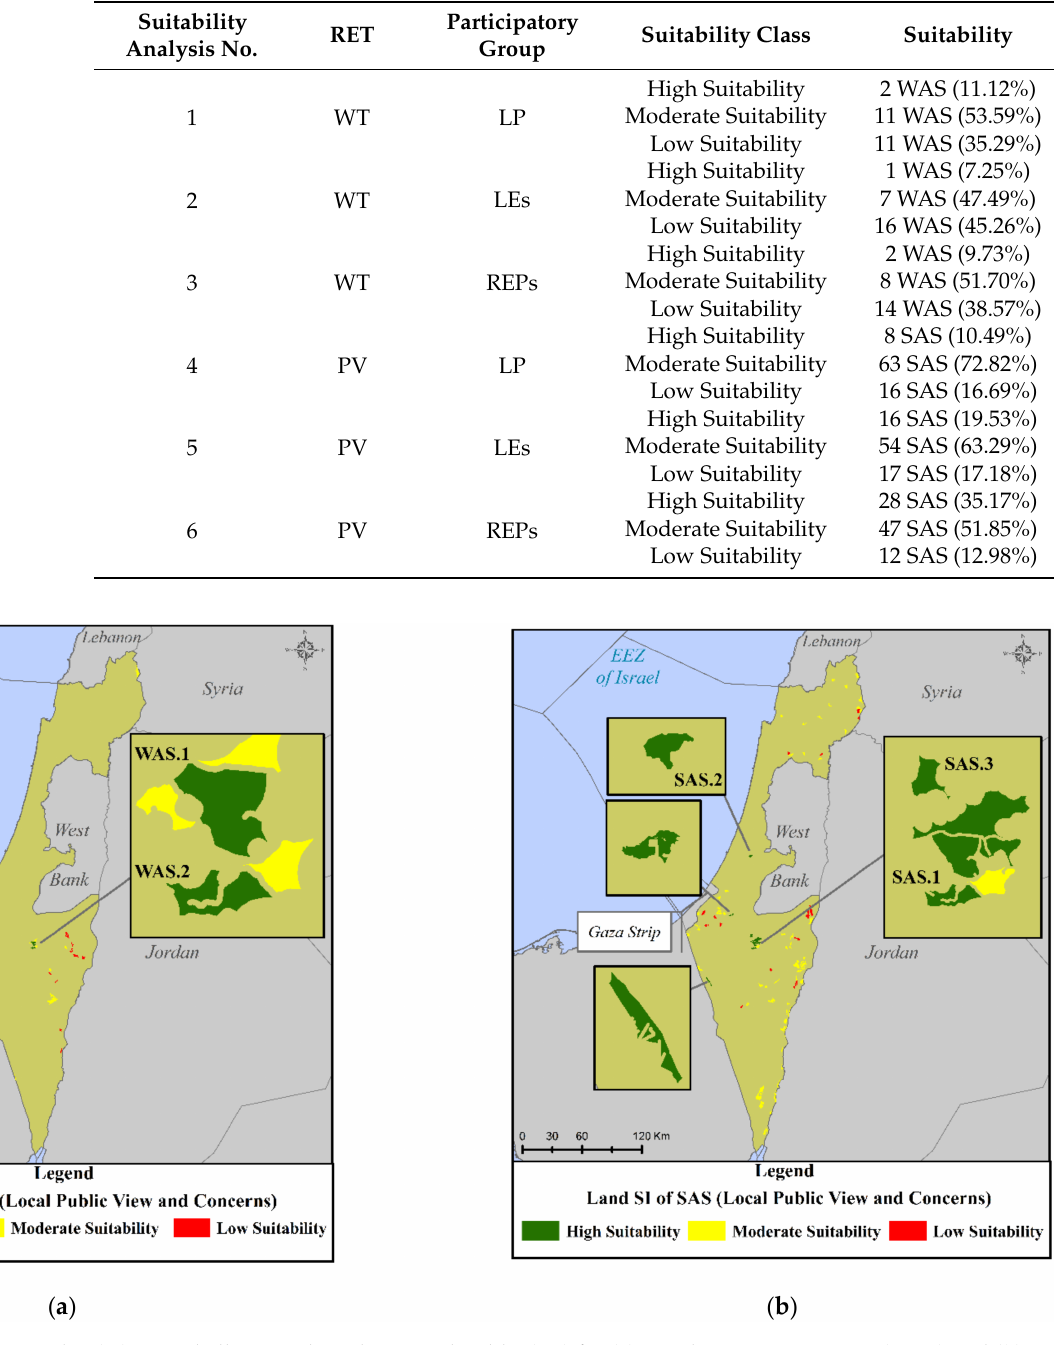
Figure 10. Suitability Index (SI) spatial allocation based on Local Public (LP) for ( a ) Wind Appropriate Sites (WAS) and ( b ) Solar Appropriate Sites